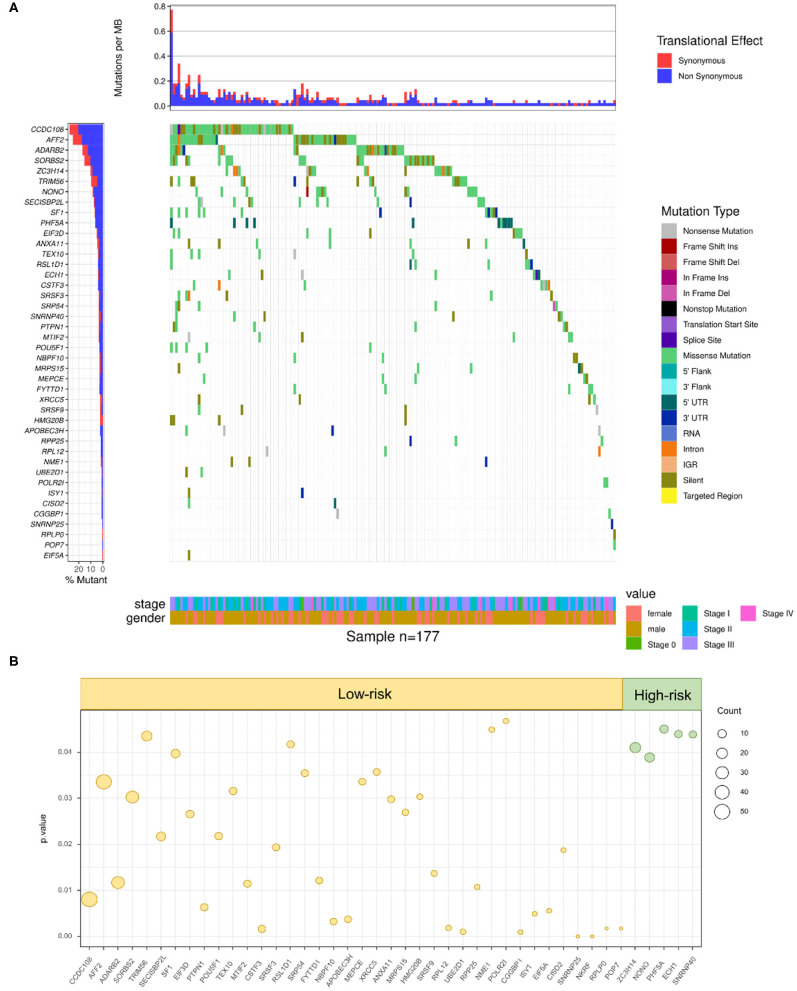
RBP mutations correlated with SKCM prognosis. (A) A total of 43 RBPs were demonstrated to carry prognosis-associated mutations (Kruskal–Wallis H test P-values < 0.05). The y-axis represents each RBP and sorted by mutation frequency. The x-axis stands for different SKCM samples. The color indicates different mutation type. The bar plot above represents the mutation frequency with synonymous (red) and non-synonymous (blue) translational effects of each sample. (B) High-risk factors (right panel) and low-risk factors (left panel) of prognosis-related RBP mutations. The circle size stands for count of samples with mutations.